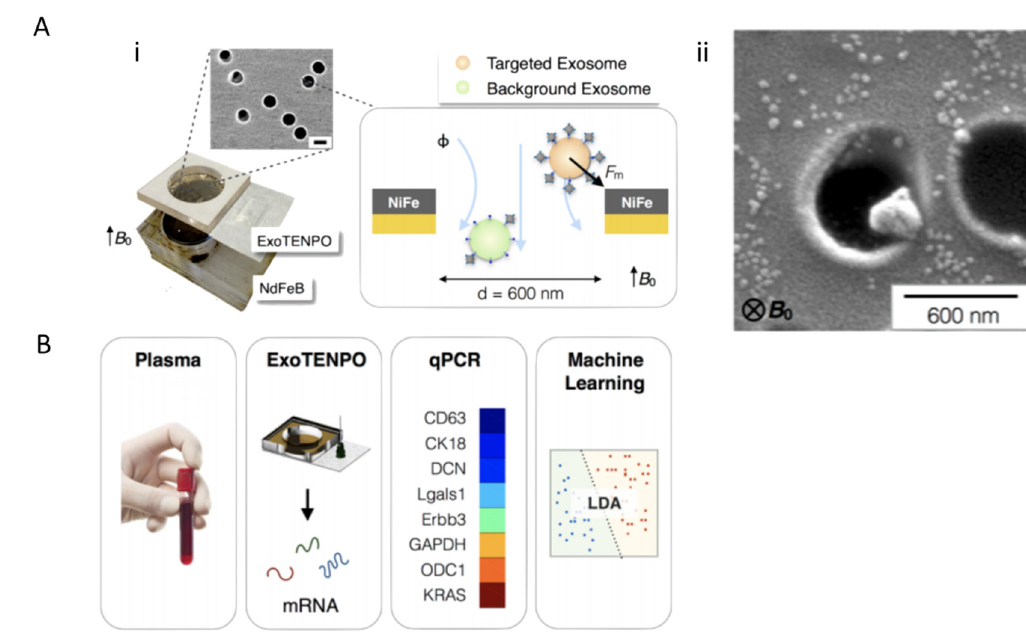
Figure 7. Example of combining exosome profiling with machine learning techniques for cancer diagnostics. ( A ) Schematic and workflow of exosome ( Aii ) tracked-etched magnetic nanopore chip (ExoTENPO) and the ( Ai ) NdFeB external magnet for detection of pancreatic cancer exosomes from plasma through ( B ) qPCR and machine-learning algorithms (Adapted with permission from Ko. J et al. 2017 American Chemical Society Nano).